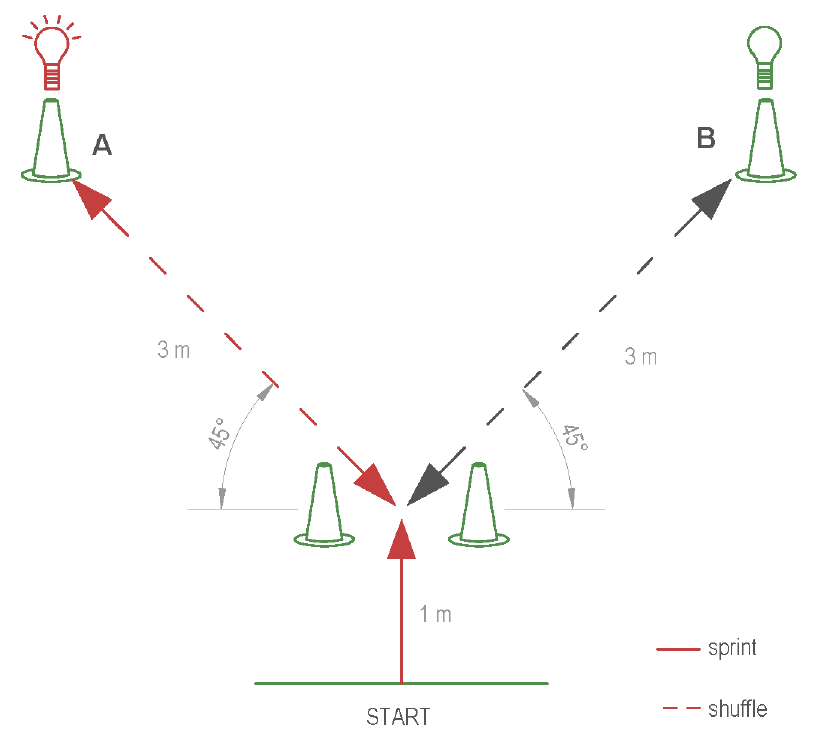
Figure 14. New Basketball-specific-non-planned agility test (BBAGIL); adapted and edited from